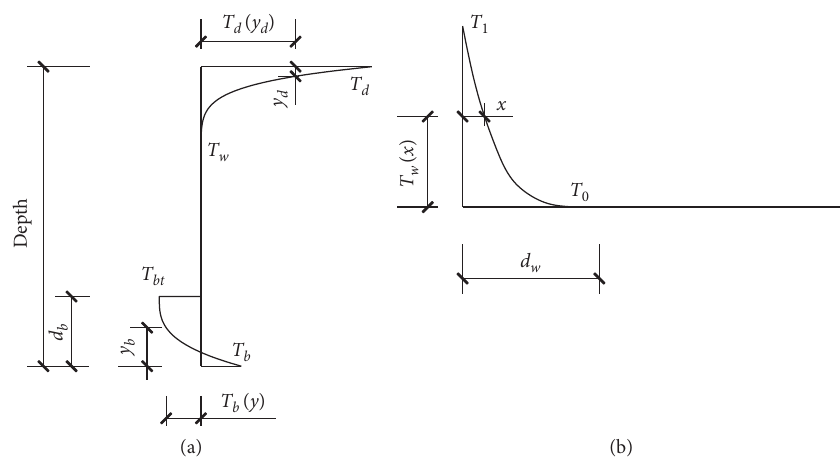
Figure 17: The proposed (a) vertical and (b) transverse temperature gradient models of the long-span PCBG bridge.